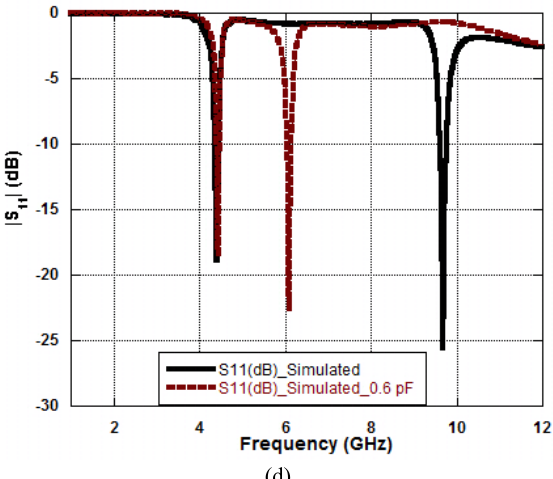
Figure 2: Simulated |S11| with and without C = 0.6